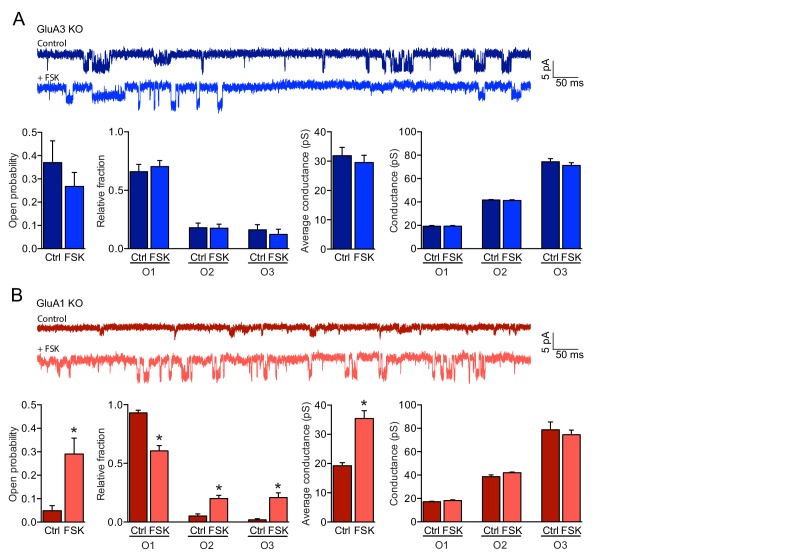
cAMP increases the open-channel probability of GluA3-containing AMPARs.(A, B) Single channel recordings under cell-attached configuration showing example traces, open probability, fraction of time spent in each open state, average conductance and conductances of each open state. (A) GluA1-containing AMPARs on GluA3-KO neurons (blue) did not respond to forskolin (ctrl: n=15, FSK: n=14) (open-channel probability: t-test, p=0.9; single-channel conductance: t-test, p=0.5). (B) The open-probability (t-test, p=0.0001) and single-channel conductance (t-test: p<0.0001) increased of GluA3-containing AMPARs on GluA1-KO neurons (red) upon incubation with forskolin (ctrl: n=15, FSK n=14). Error bars indicate SEM, * indicates p<0.05.